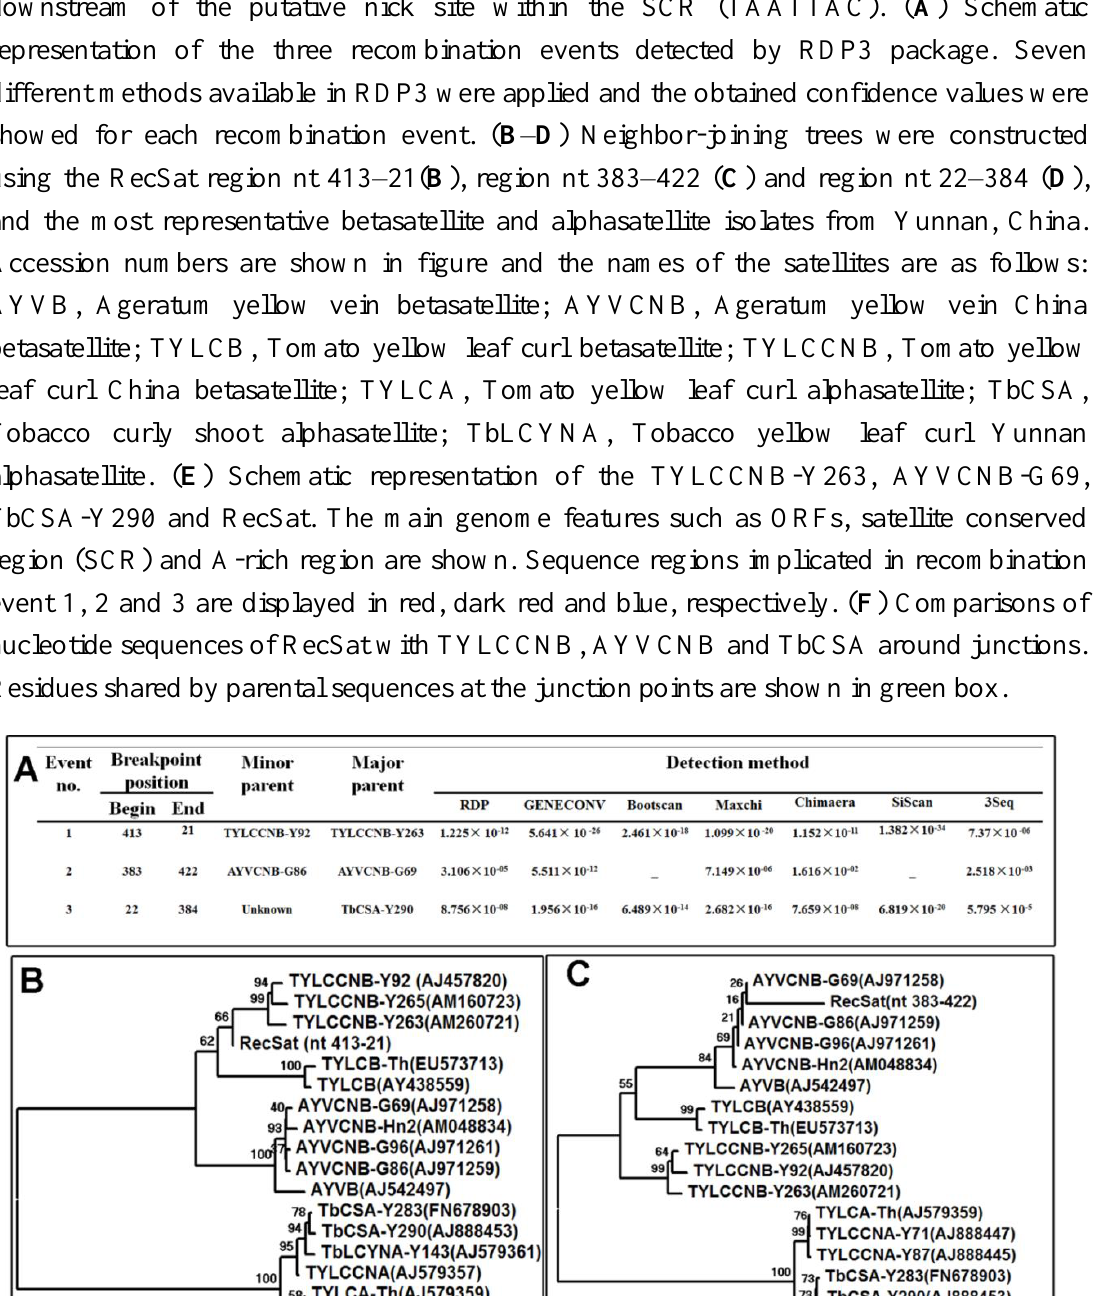
Figure 2. Recombination analyses illustrating the positions of recombination events 1, 2 and 3. The nucleotide position 1 of RecSat has been defined as the A residue